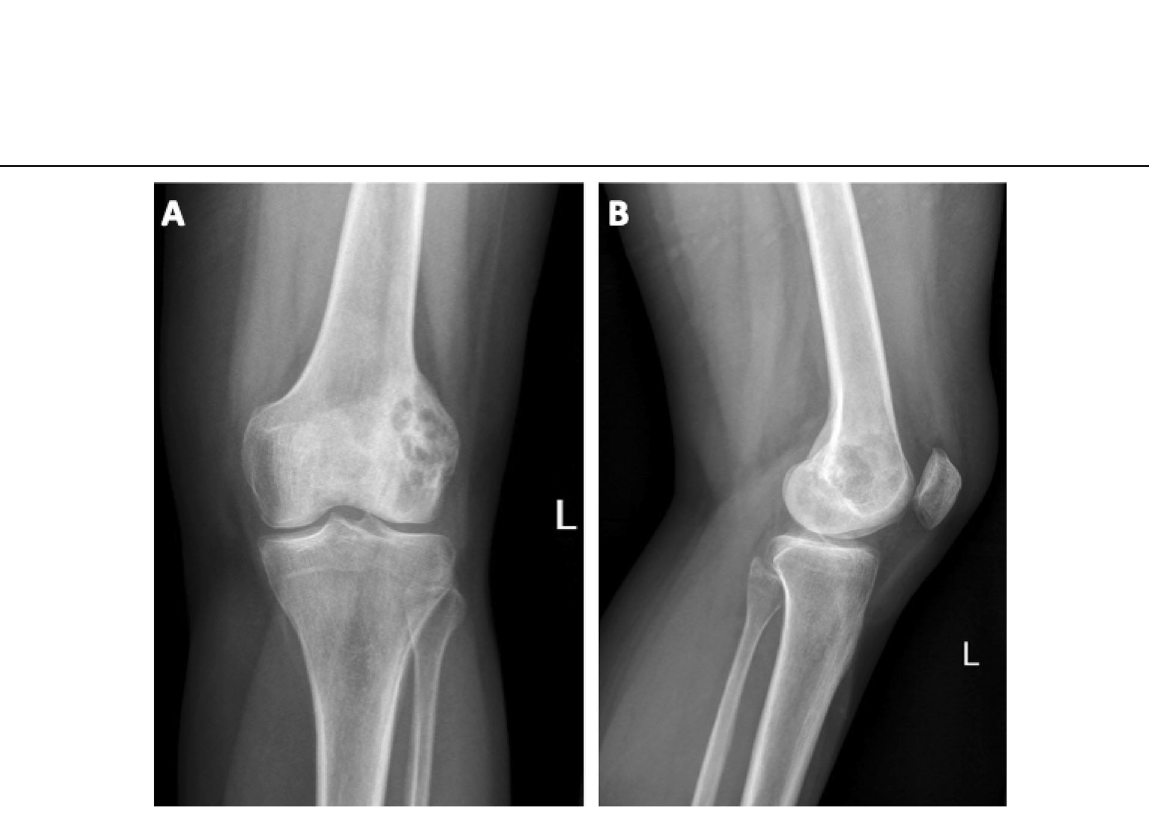
Fig. 4 a Anteroposterior and b lateral radiographs of the left knee in a 52 year old female showing a mixed sclerotic and lucent lesion within the lateral femoral